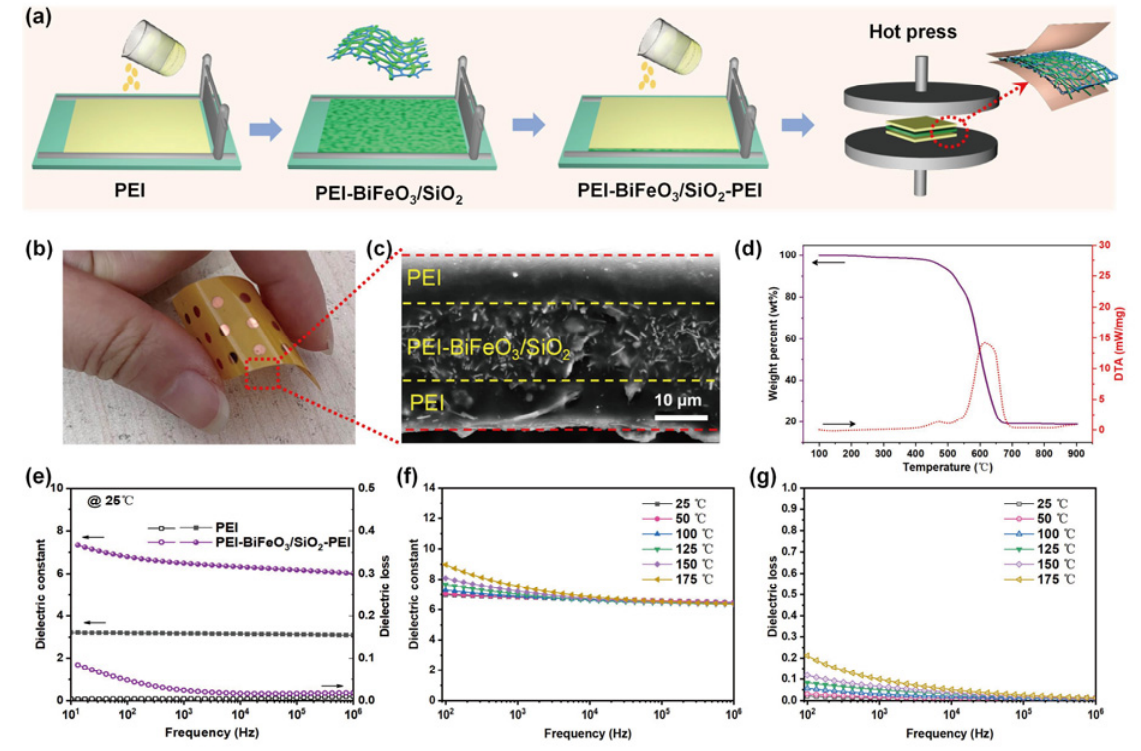
Fig. 4 Processing, architecture, and dielectric properties of 3D composite film. (a) Schematic illustration of the fabrication process of 3D composite film. (b, c) Optical photograph and cross-section SEM image of 3D composite film, respectively. (d) Thermogravimetric analysis (TGA) and differential thermal analysis (DTA) curves of 3D composite film. (e) Dielectric constant and dielectric loss of pristine PEI film and 3D composite film at 25 ℃ as a function of frequency. (f) Dielectric constant and (g) dielectric loss of 3D composite film at various